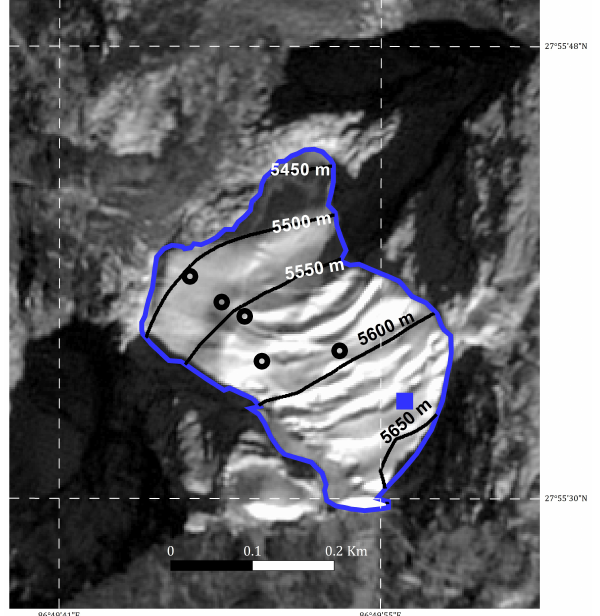
Fig. 3. Maps of Pokalde Glacier, showing the network of abla- tion stakes (grey circles), the accumulation measurement site (blue square). Background: SPOT5 image of 4 January 2011 (CNES 2011/Distribution